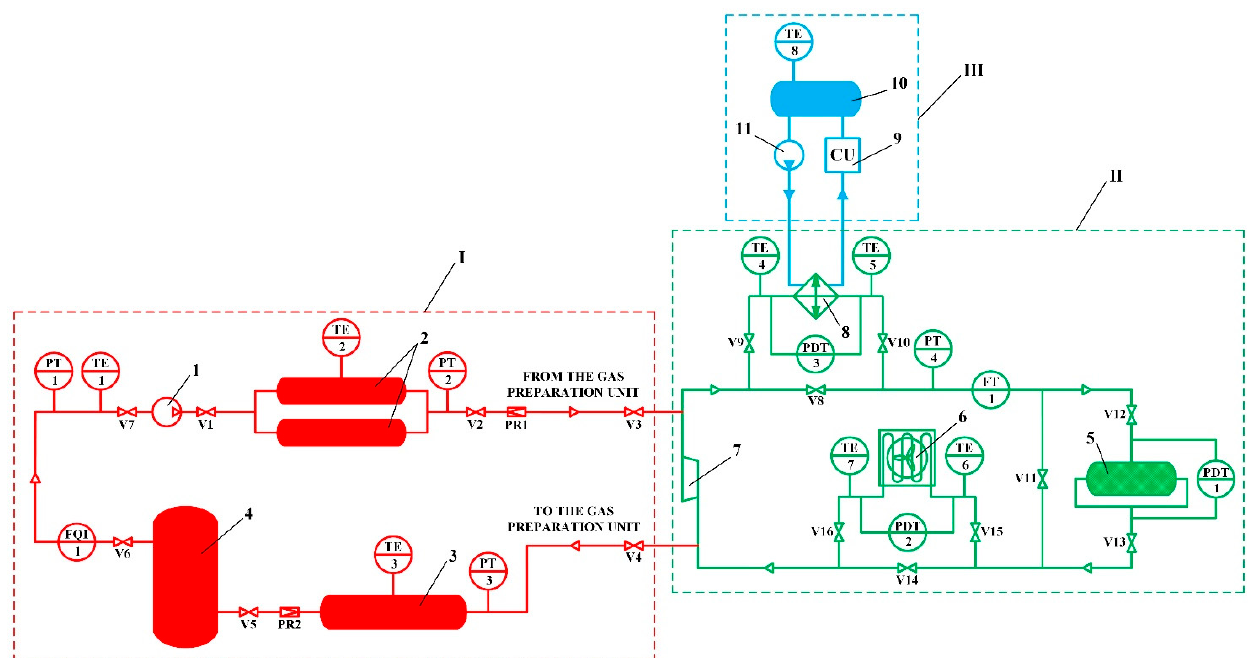
Figure 3. Schematic diagram of the experimental setup for study of the thermal management process during circulating charging of the ANG storage system. I—high pressure gas preparation unit; II—circulating charging unit; III—coolant preparation unit; 1—natural gas compressor; 2—high pressure tank; 3—medium pressure tank; 4—low pressure tank; 5—ANG storage system (adsorption tank); 6—“natural gas–air” heat exchanger; 7—supercharger; 8—“natural gas–ethanol” heat exchanger; 9—cooling unit; 10—ethanol tank; 11—circulation pump; PR1–2—pressure regulators; V1–16—stop valves; PT1–4—pressure sensors; PDT1–3—differential pressure sensors; TE1–8—temperature sensors; FT1—flow sensor; FQI1—gas flow meter.